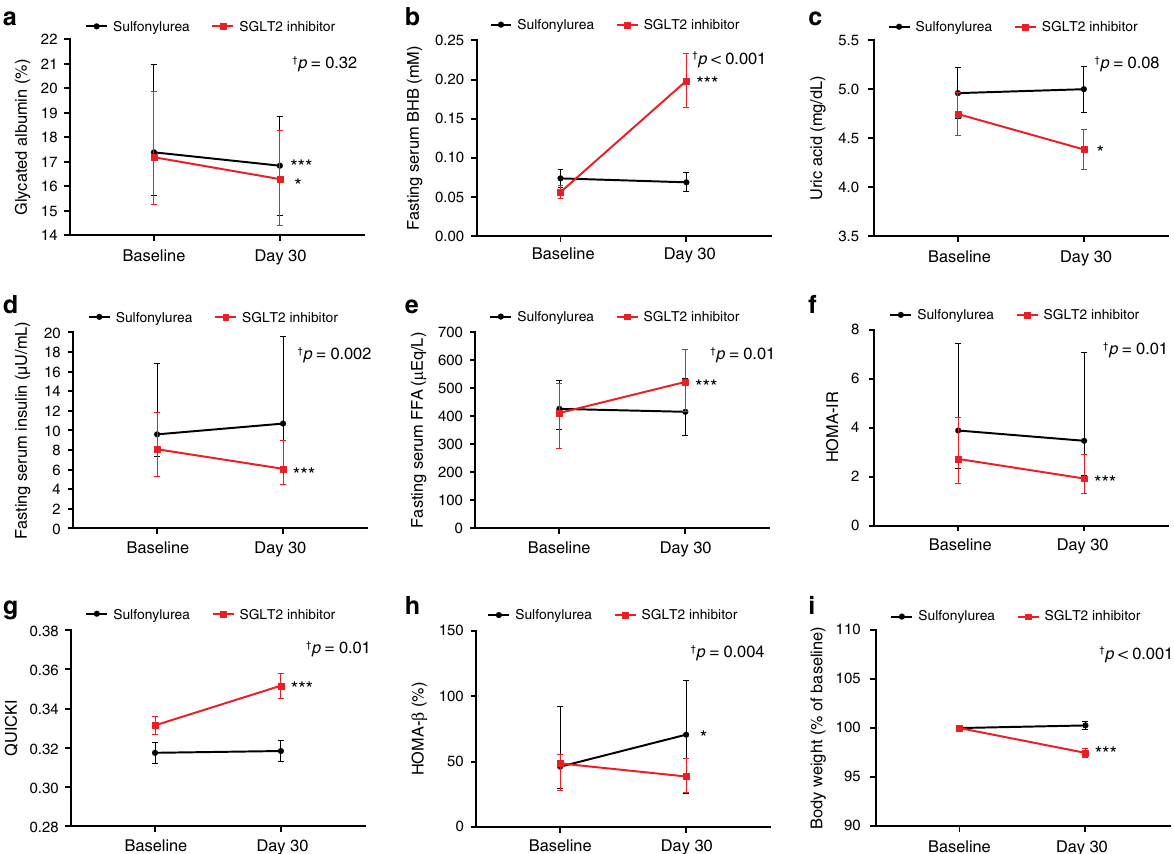
Fig. 2 Effects of SGLT2 inhibitor and sulfonylurea on metabolic parameters. a – i Changes in metabolic parameters from baseline to end of treatment (sulfonylurea group: n = 32, SGLT2 inhibitor group: n = 29). † Statistical signi fi cance for the time × group interaction evaluated by repeat-measures analysis of variance (ANOVA) (Non-normally distributed variables were log transformed for analysis and back transformed for presentation). Data are represented as mean ± SEM or median (interquartile range). Two-sided paired t test or Wilcoxon signed rank test; * P < 0.05, ** P < 0.01, and *** P < 0.001